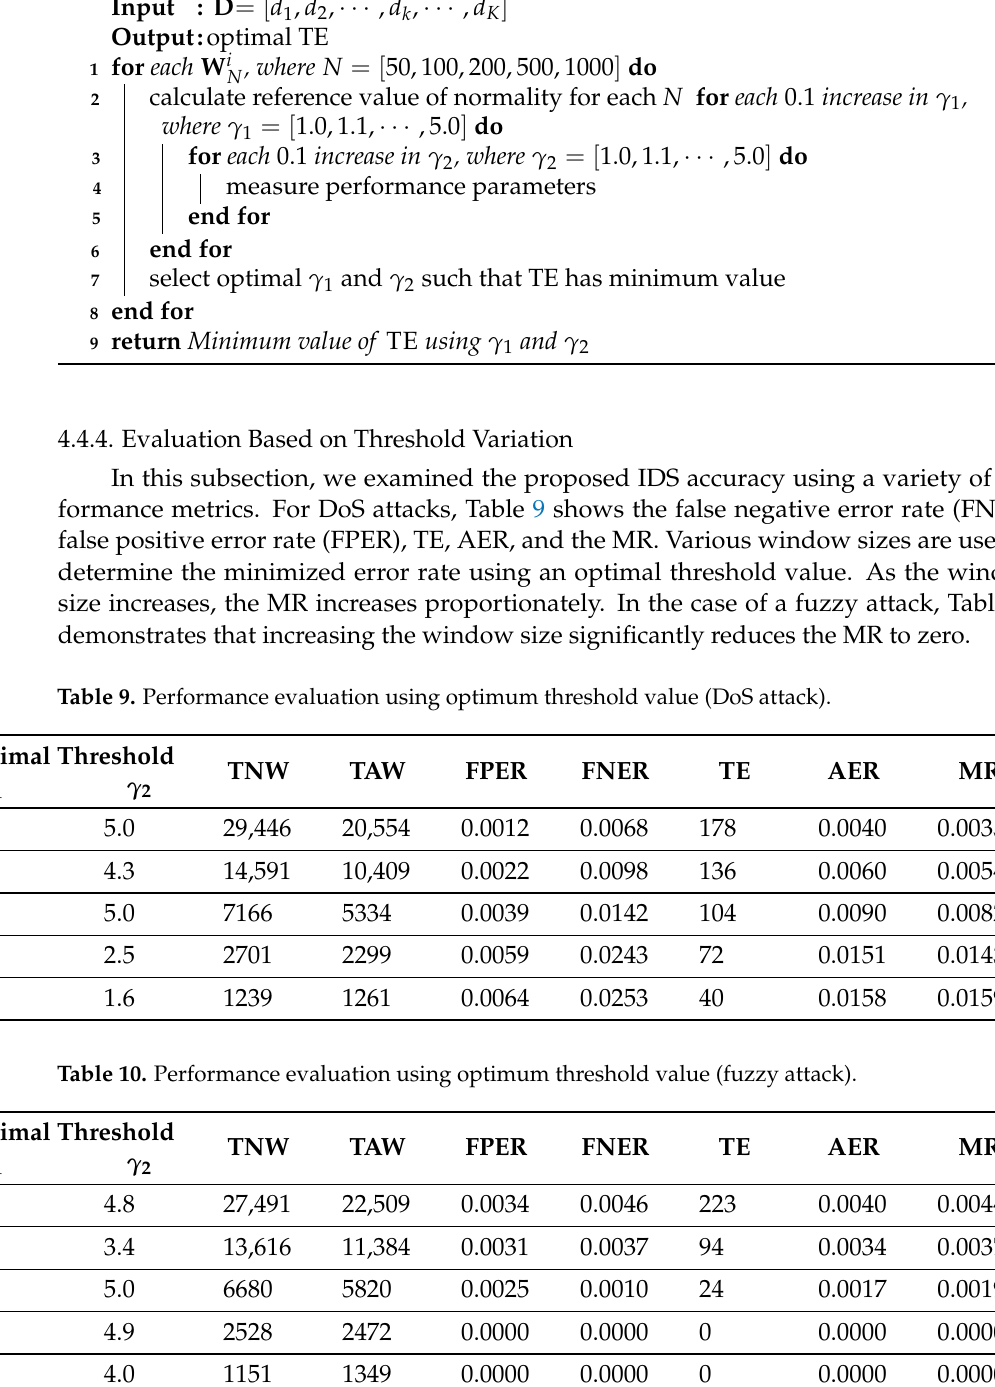
Algorithm 1: Minimum value of TE